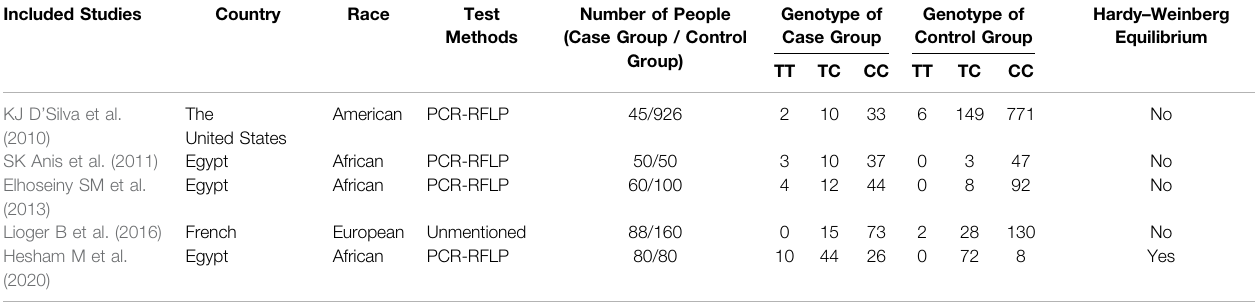
TABLE 2 | Basic features of the included articles about research of correlation between SNP1858 and ITP susceptibility. Included Studies